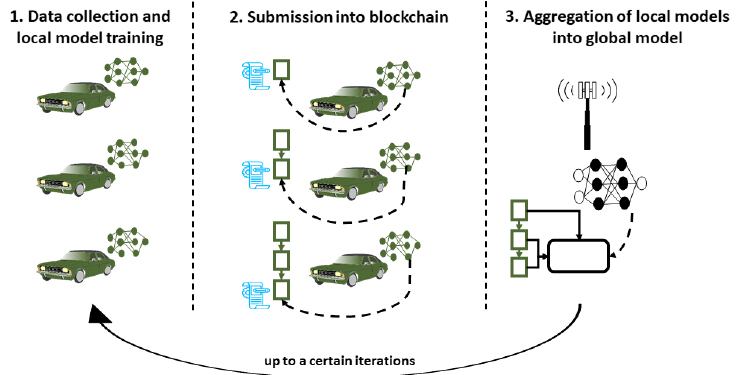
Figure 3. The proposed solution of blockchain-enabled FL in